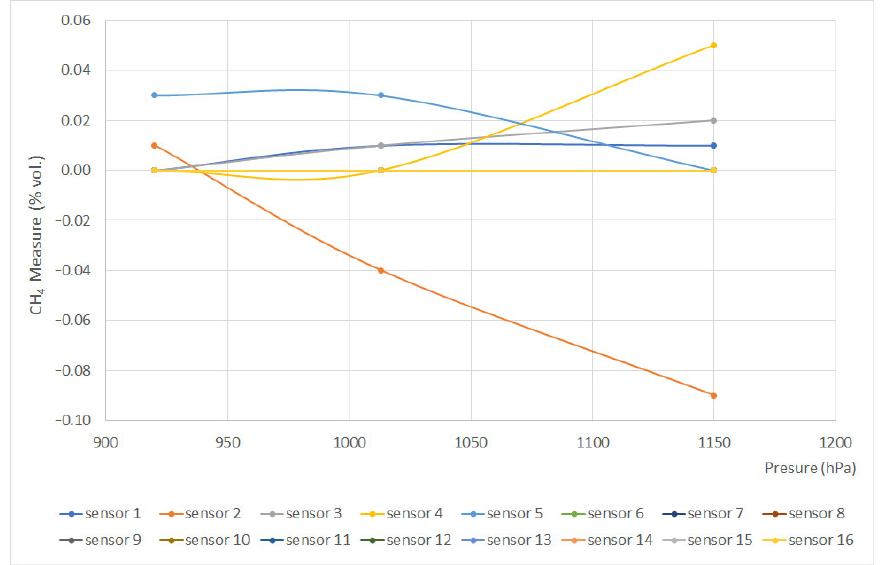
Figure 6. Pressure curves for 0% vol. (Some measures present the same data, therefore some lines are overlapped).